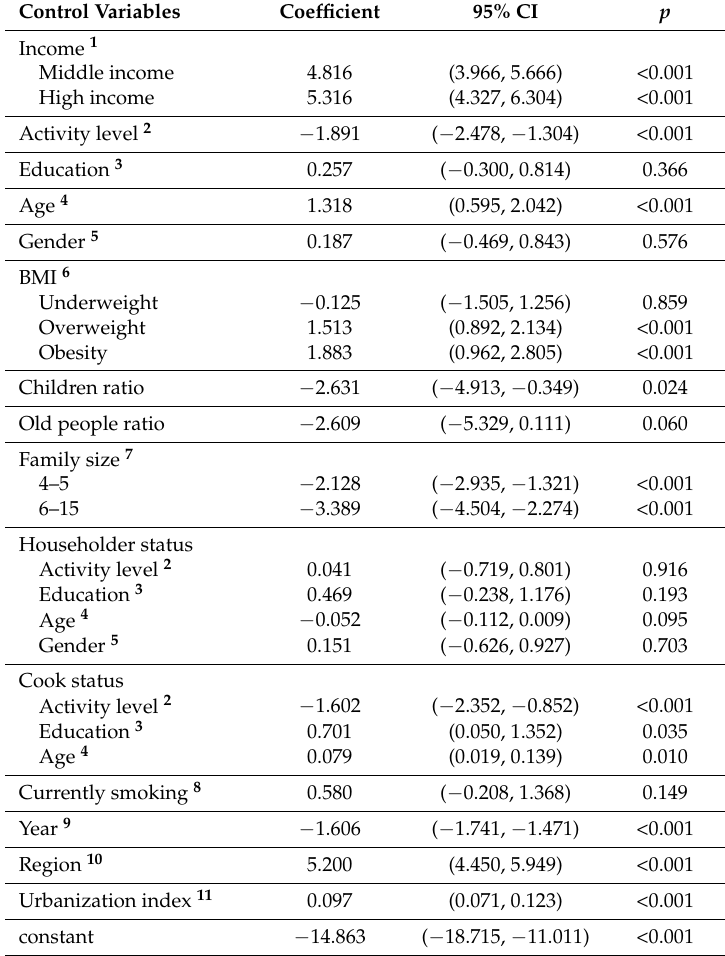
Table 3. Association between DQI scores and control variables as determined by multivariate ordinary least squares regression ( n